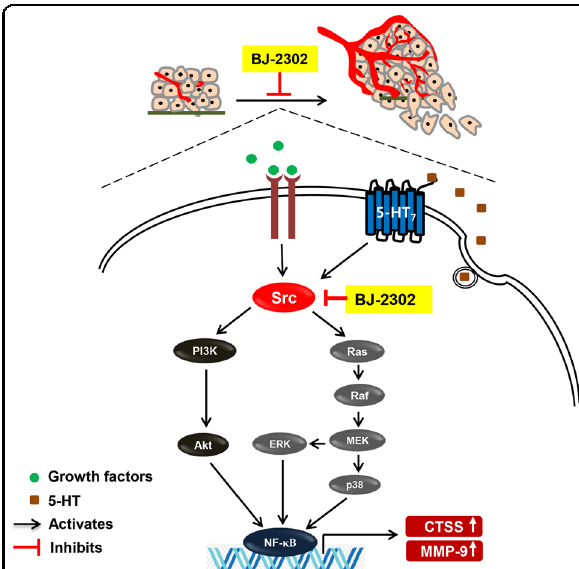
Fig. 8 Proposed signaling mechanism for the anti-cancer effect of BJ-2302, a Src inhibitor, in MDA-MB-231 human TNBC cells. The anti-metastatic, anti-tumor effect of BJ-2302 was mediated by the down-regulation of CTSS and MMP-9 protein expression via suppression of Src-mediated dual activation of the PI3K/Akt and Ras/Raf/ERK